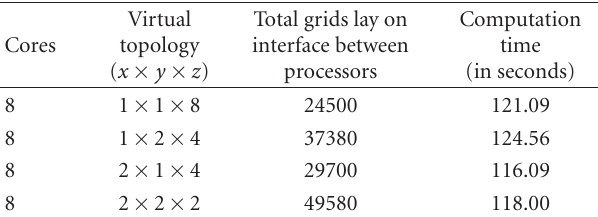
Table 2: Comparisons of computation